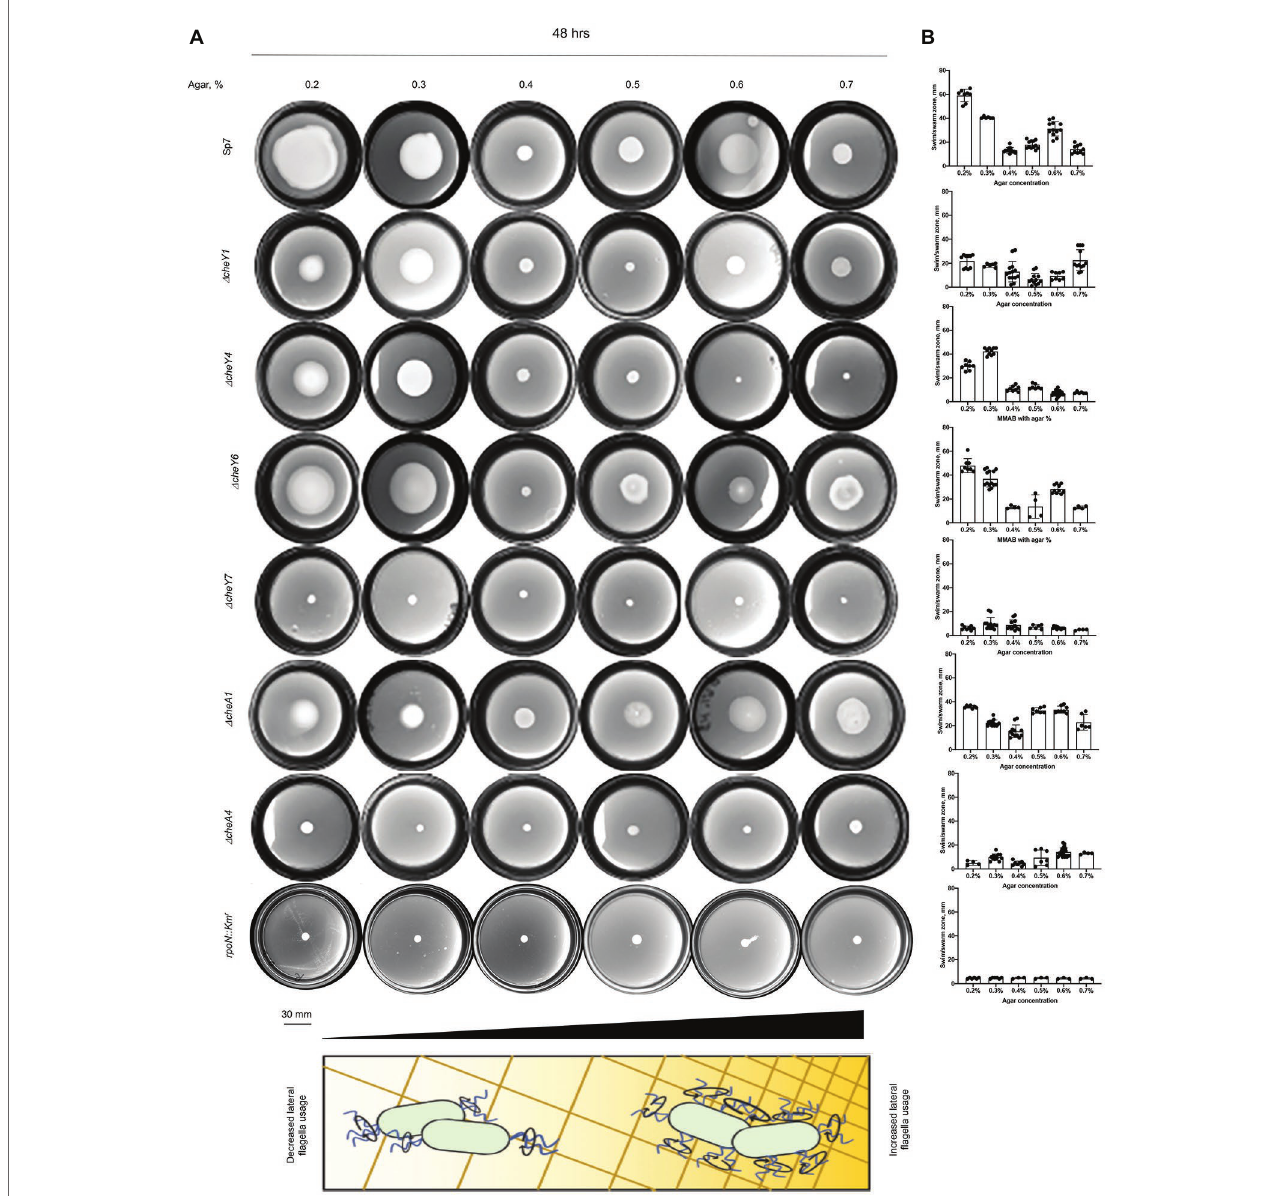
FIGURE 4 | Navigation of A. brasilense and its chemotaxis mutant derivatives in soft agar media of varying viscosity. (A) Chemotaxis behavior of A. brasilense Sp7, ΔcheY1 , ΔcheY4 , ΔcheY6 , ΔcheY7 , ΔcheA1 , ΔcheA4 , and rpoN::Km r strains in the semi-solid medium supplemented with 0.2–0.7% agar. The triangle at the bottom and the scheme represents increasing concentrations of agar. (B) Quantitation of the swimming/swarming ring diameters. Arrows indicate a significantly higher swimming/swarming diameter of the colonies in the mutant strains than Sp7. Student t -test was used to determine significance between Sp7 and mutants. * p < 0.05, ** p < 0.01, *** p < 0.005, and **** p < 0.001. All studies were done in three biological